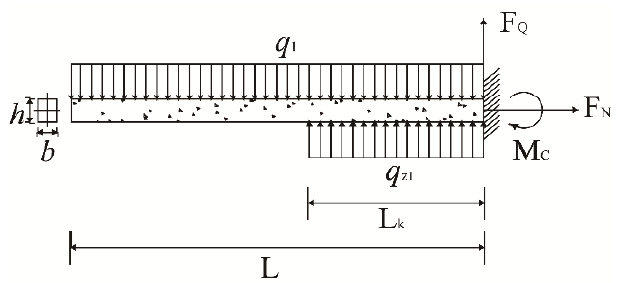
Figure 7. Cantilever structure of KS1.